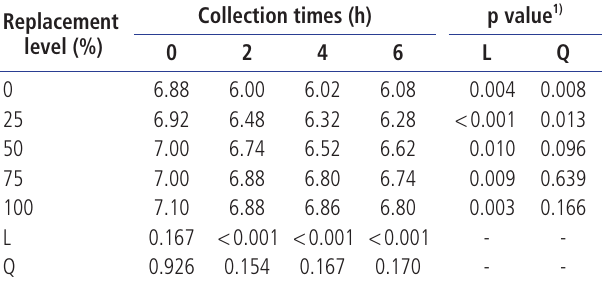
SEM, standard error of the mean; Treat, treatment (replacement levels). Table 6. Average means of ruminal pH in function of collection times for steers fed cactus cladodes plus urea Replacement level